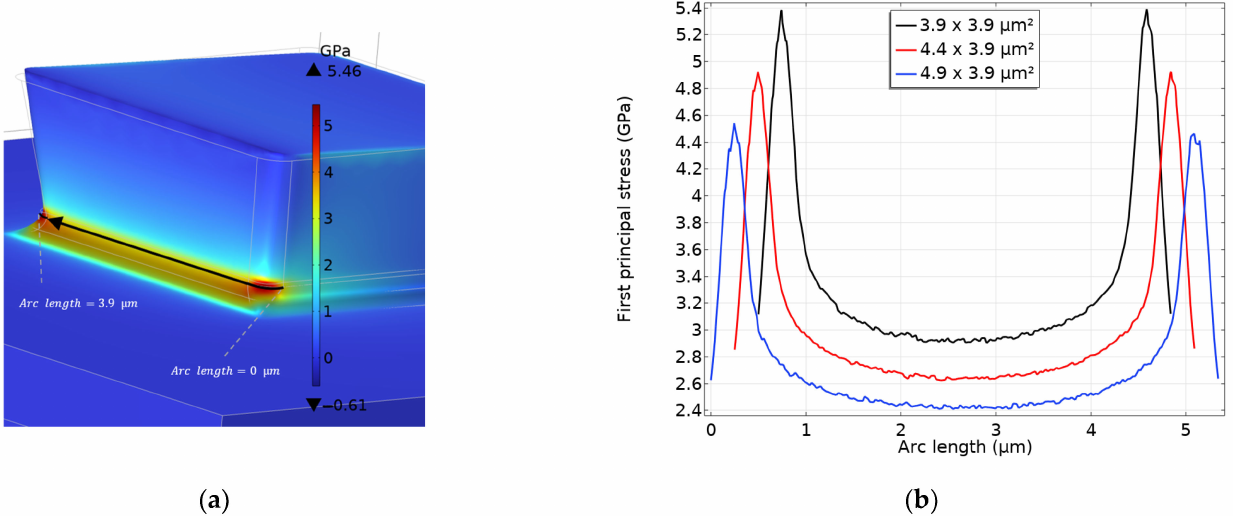
Figure 4. ( a ) Schematization of the path along the front surface of the stopper, where the stress profiles in ( b ) have been obtained with dedicated FE simulations for the three stopper